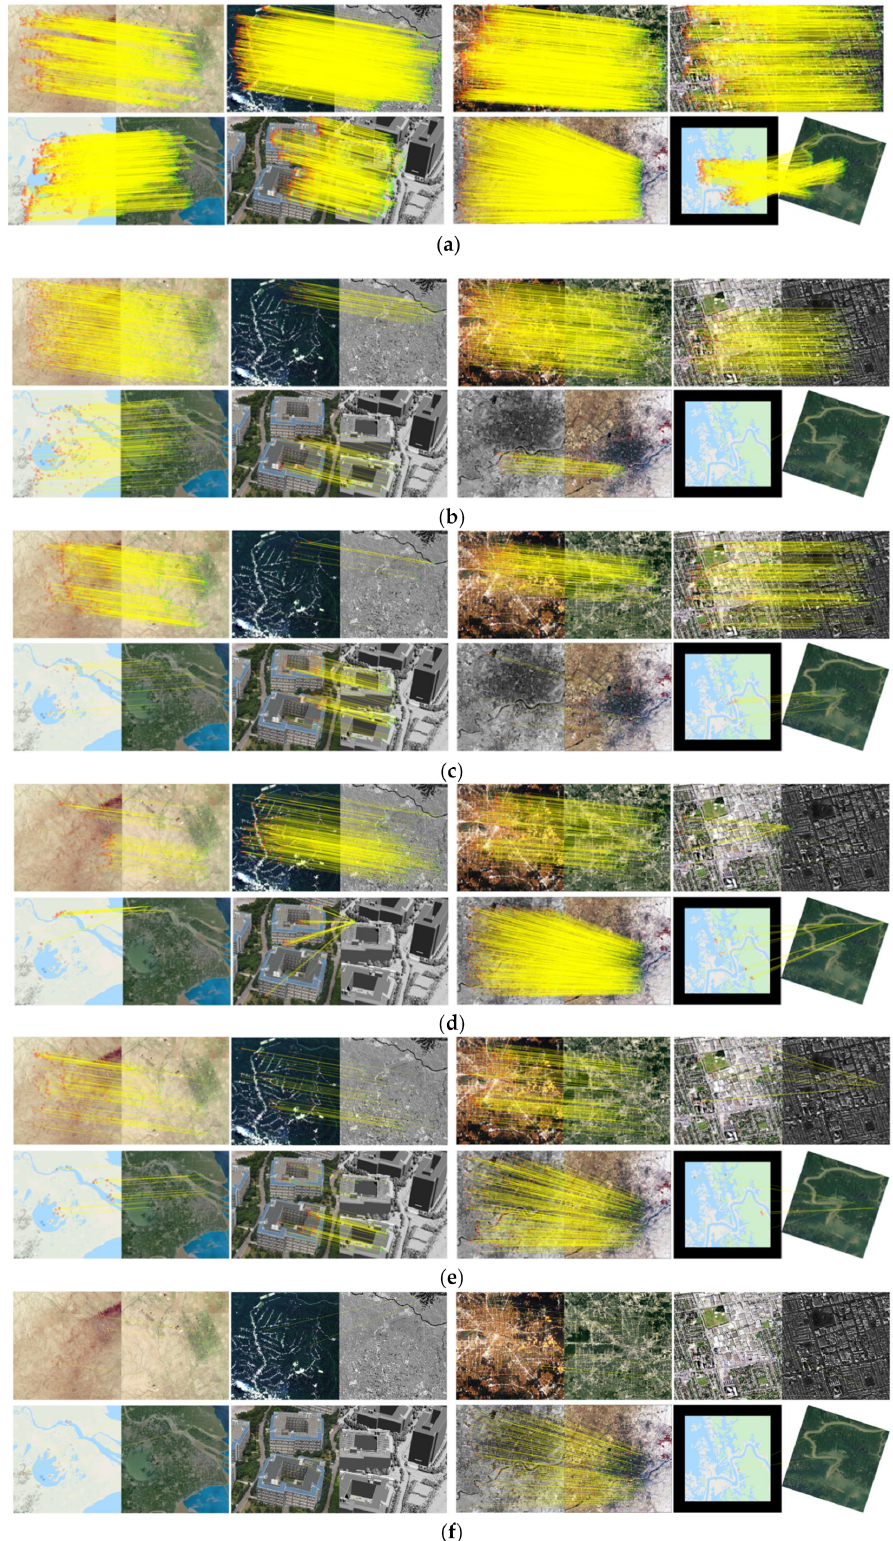
Figure 9. Qualitative comparison results of the sample data: ( a ) Results of G-CoFTM; ( b ) Results of CoFSM; ( c ) Results of RIFT; ( d ) Results of HAPCG; ( e ) Results of LPSO; ( f ) Results of